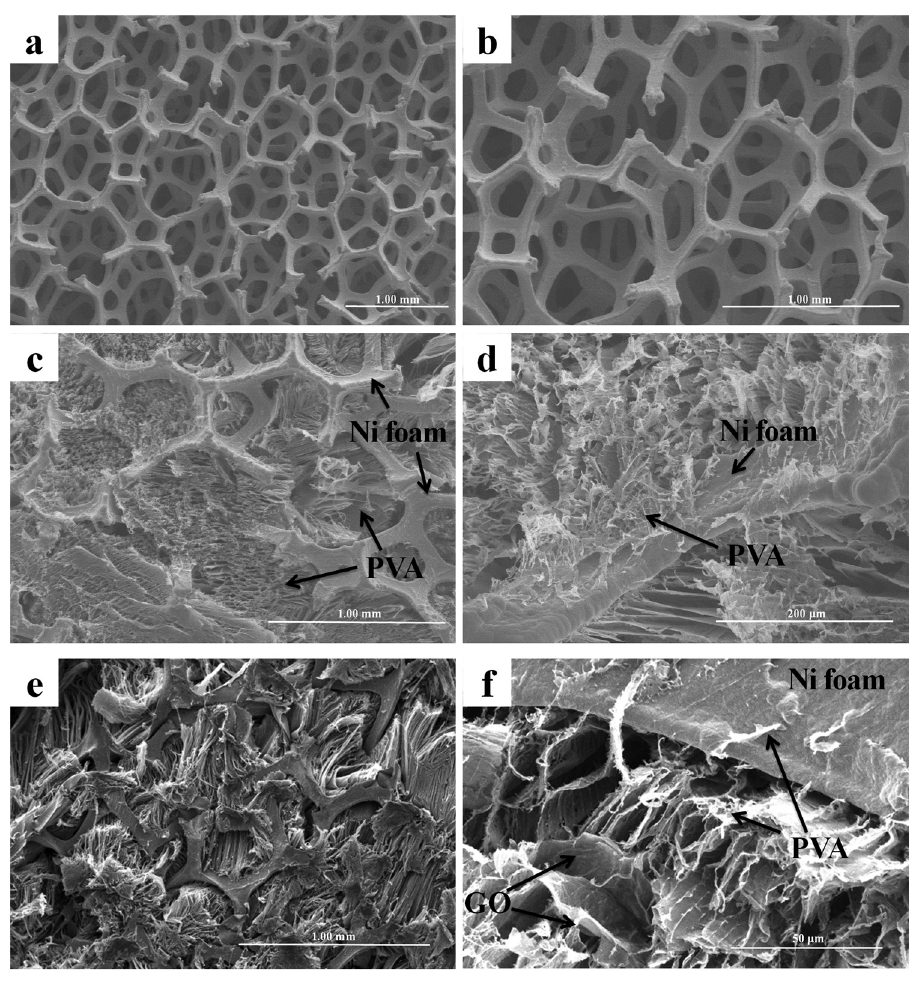
Figure 4: SEM photographs: ( a and b ) Ni foam; ( c and d ) Ni/PVA aerogels; ( e and f ) Ni/GO/PVA - 20 aerogels.